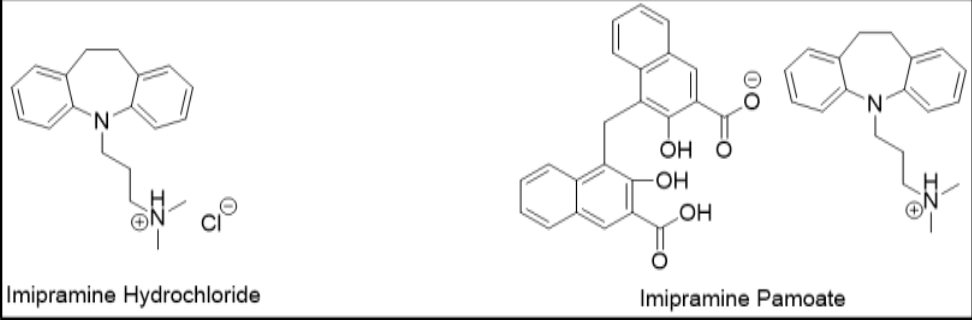
Figure 3. Salts of imipramine.